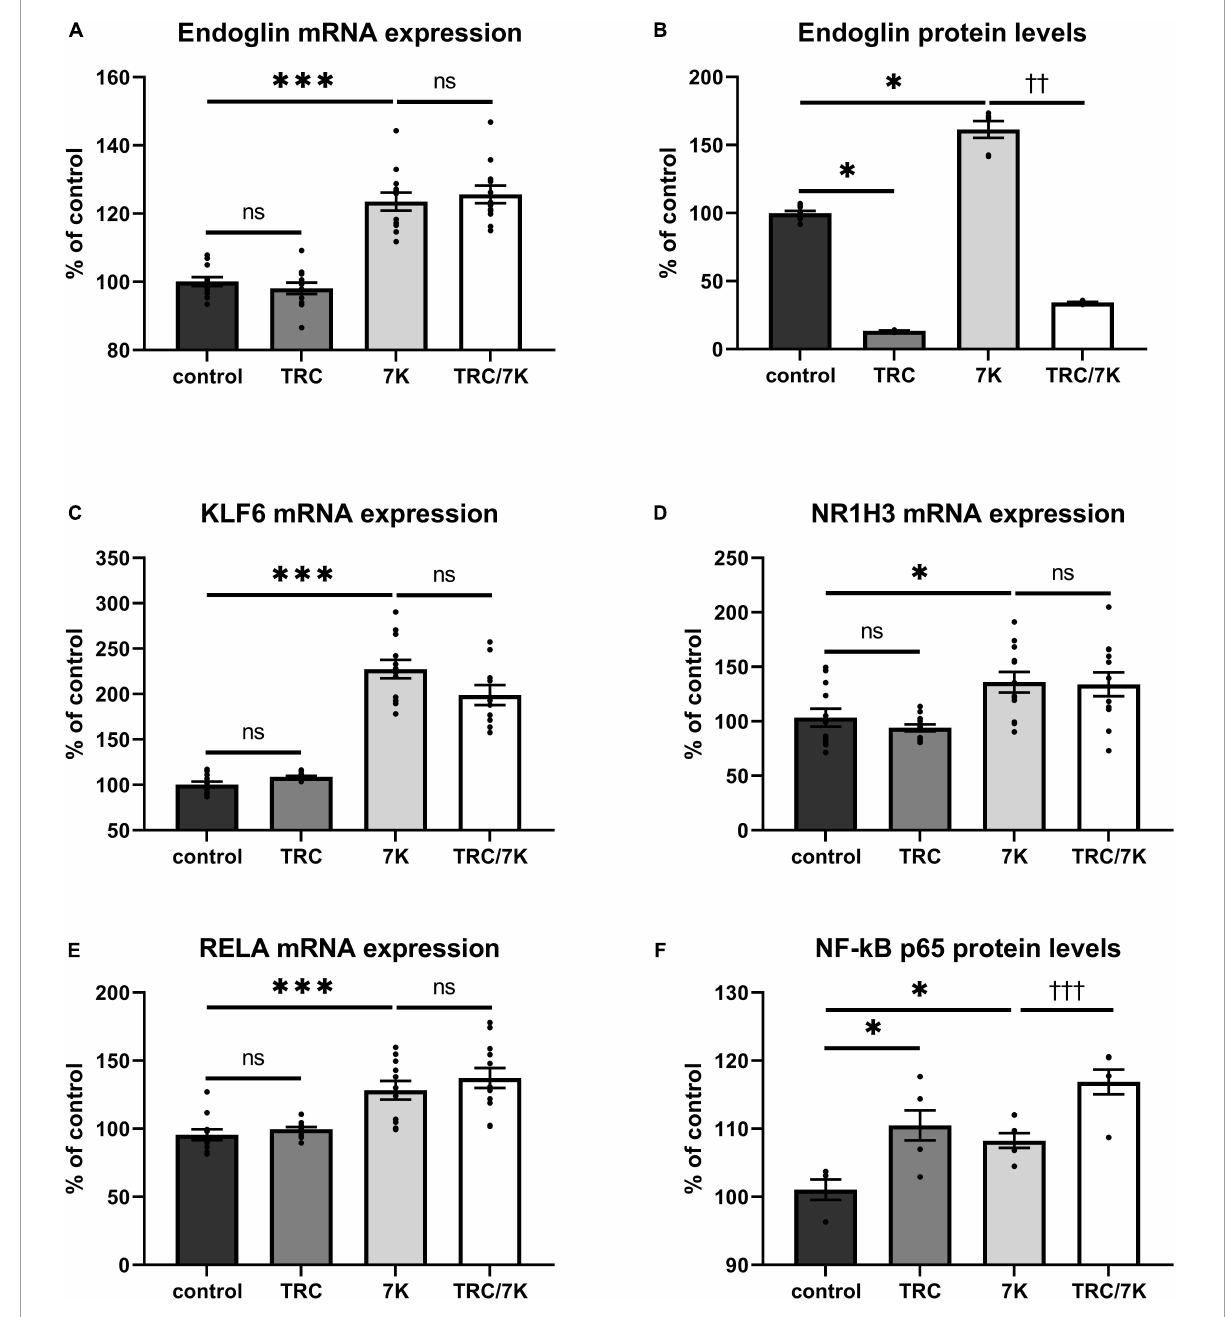
FIGURE2 Effect of TRC105 on 7K-induced mRNA and protein expression of Eng, and on the transcription factors KLF6, NR1H3 and RELA (NF- κ B p 65) in HAoECs. (A) Eng mRNA expression. (B) Eng protein levels. (C) KLF6 mRNA expression. (D) NR1H3 mRNA expression. (E) RELA mRNA expression. (F) NF- κ B p65 protein levels. For the detailed experimental design, please see Figure 1 . The data are presented as mean ± S.E.M ( n = 6). ns, p ≥ 0.05; ∗ p < 0.05; ∗∗∗ p < 0.001, using Kruskal–Wallis test for comparisons between control, TRC and 7K, and †† p < 0.01; ††† p < 0.001, using Mann–Whitney test for comparison between 7K vs TRC/7K.